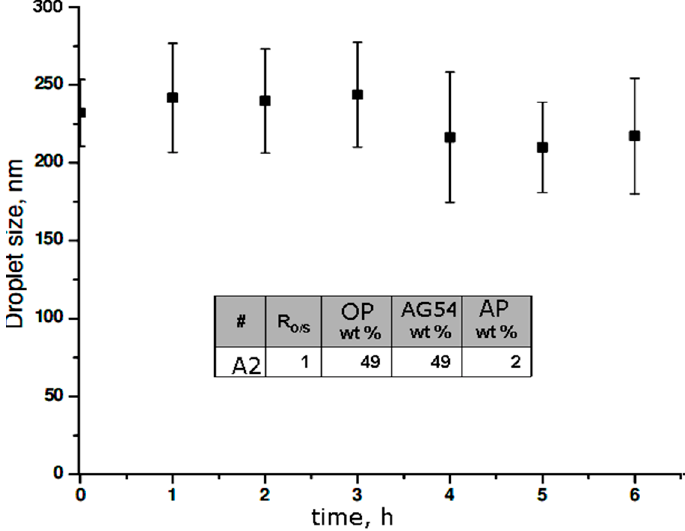
Figure 10. Drop size as a function of time for selected NEs for the OP//AG54//AP system at T = 25 °C.